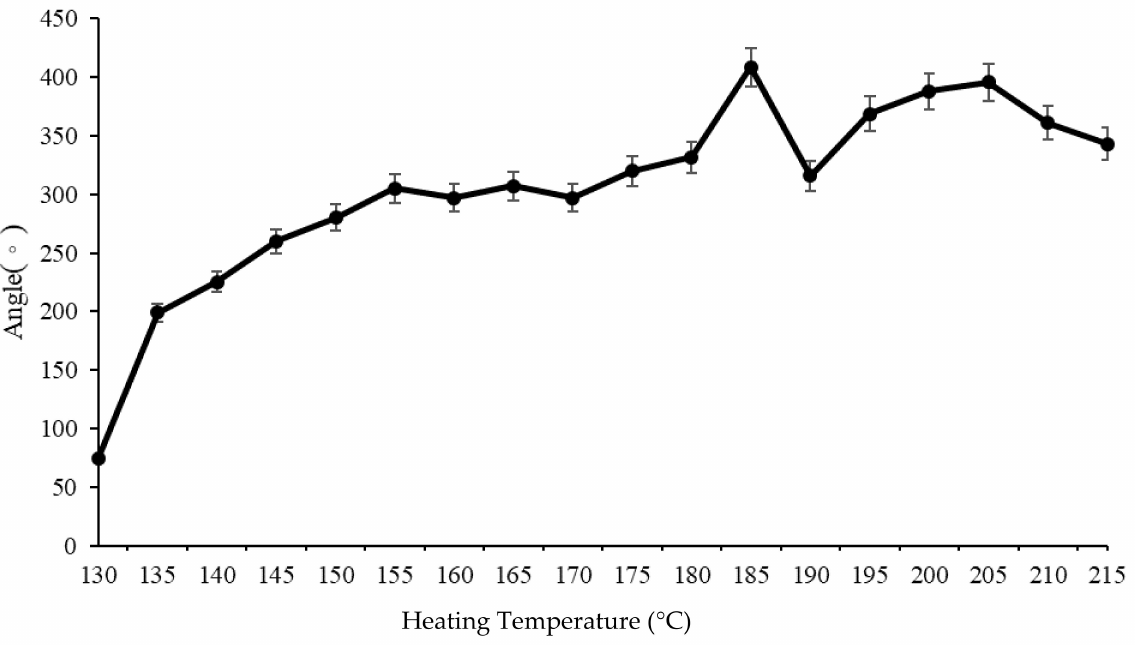
Figure 5. Deformation angles of the stimulus-responsive composite material for at various heating temperatures (with a heating time of 20